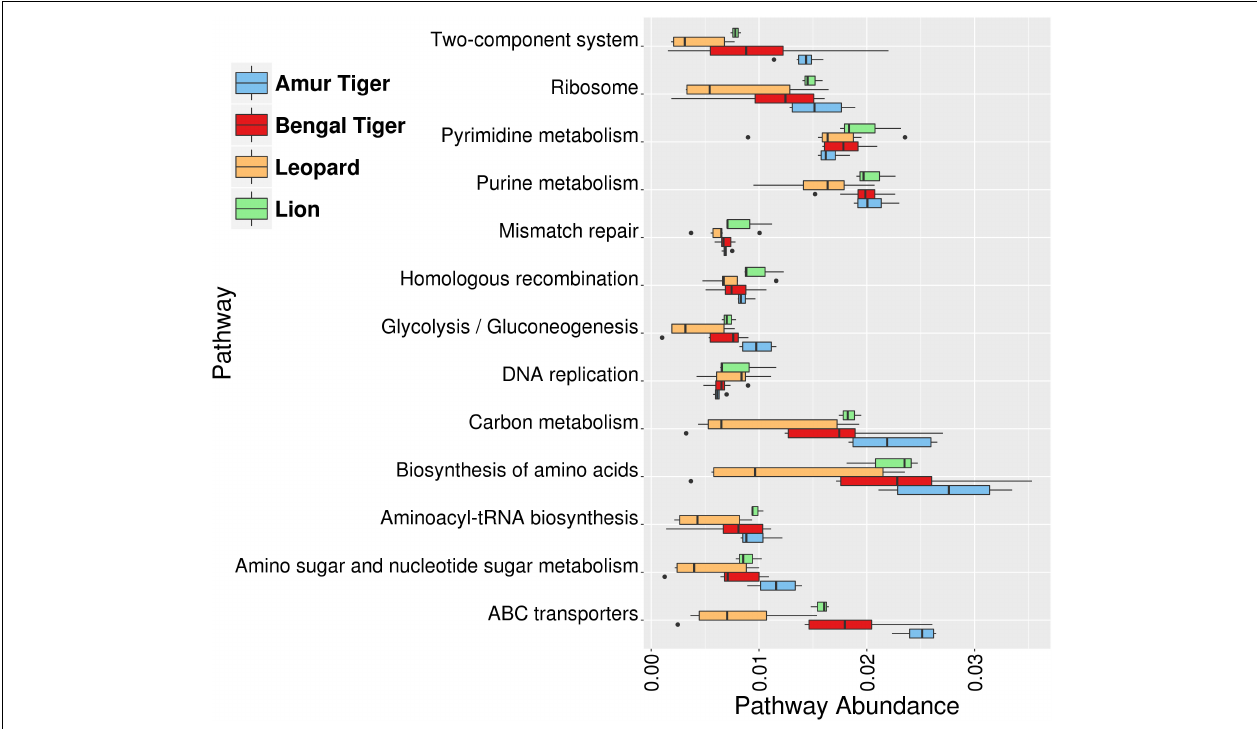
FIGURE 5 | Box plots showing the top 10 most abundant functional pathways identified using the Kyoto Encyclopedia of Genes and Genomes (KEGG) annotation in gut (bacterial) microbiome of lion (green), leopard (orange), Bengal tiger (red), and Amur tiger